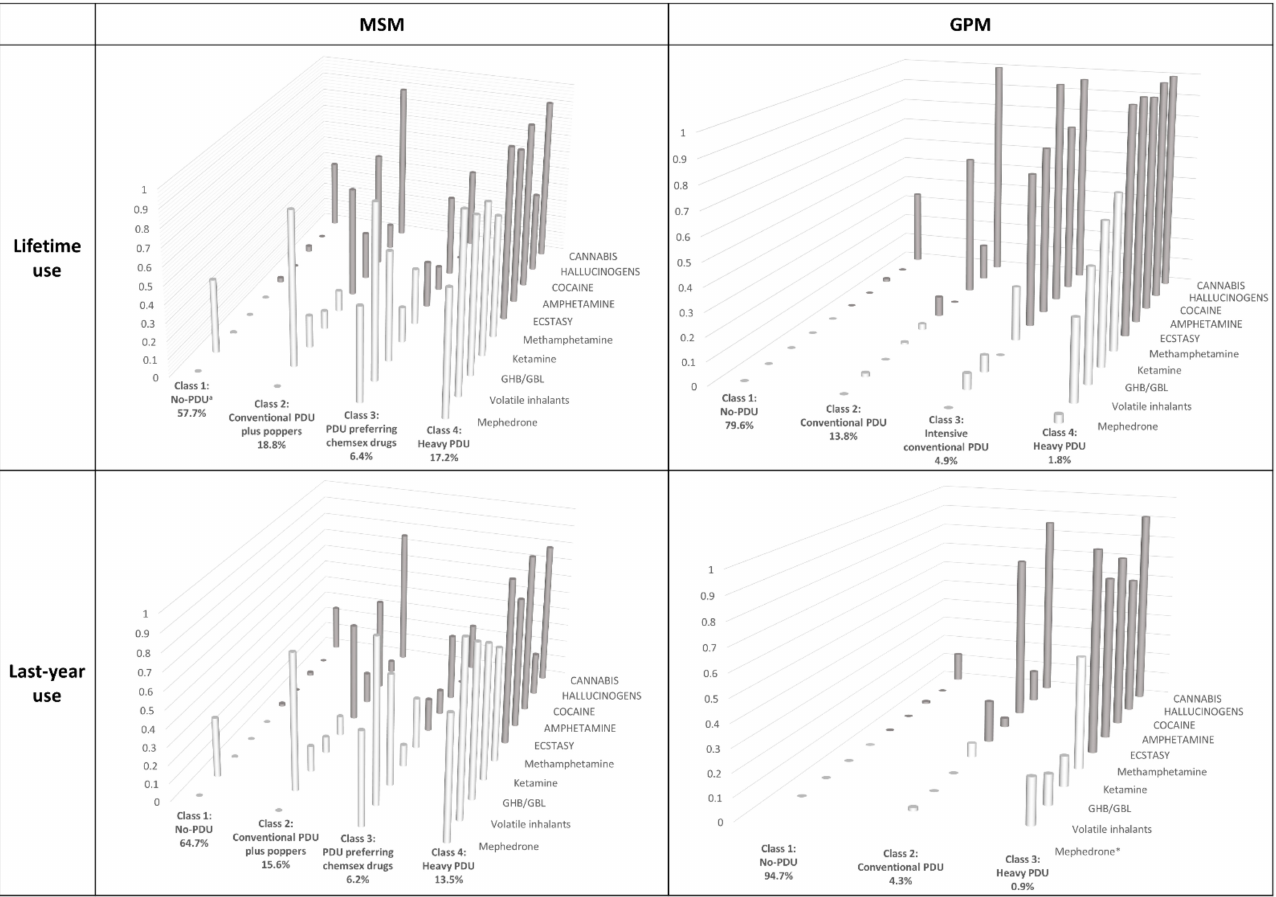
Figure 1. Results of Latent Class Analysis among men who have sex with men (MSM) and general-population men (GPM) for lifetime and last-year use: classes, prevalence of each class and conditional probabilities. a Polydrug use. * Mephedrone is not displayed because there were no reported users for last-year among GPM. White bars: “More traditional drugs”; Black bars: “chemsex